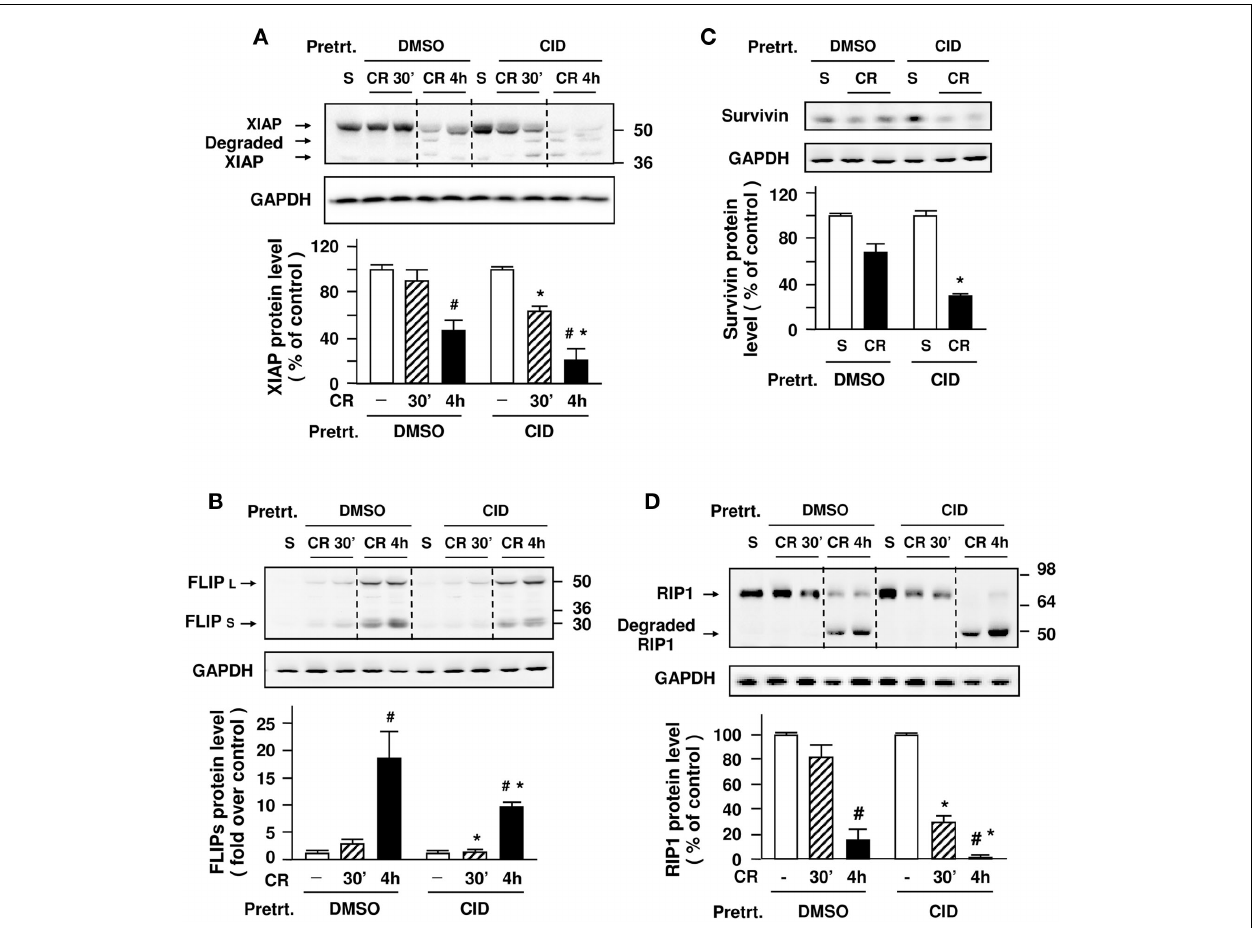
were re-probed for GAPDH to confirm equal protein loading.The bar figures are the quantification of these protein band intensities that were normalized on the band intensity in control animals injected with saline (S). Graphs show means ± SE ( n = 4) for each condition. * P < 0.05 versus cerulein alone (DMSO + CR) in first injection and fourth injection